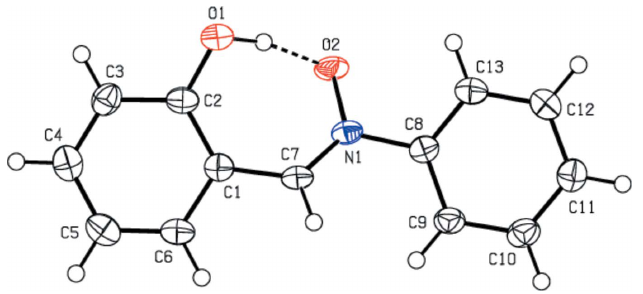
Table 1 Hydrogen-bond geometry (A˚ , (cid:4) ).